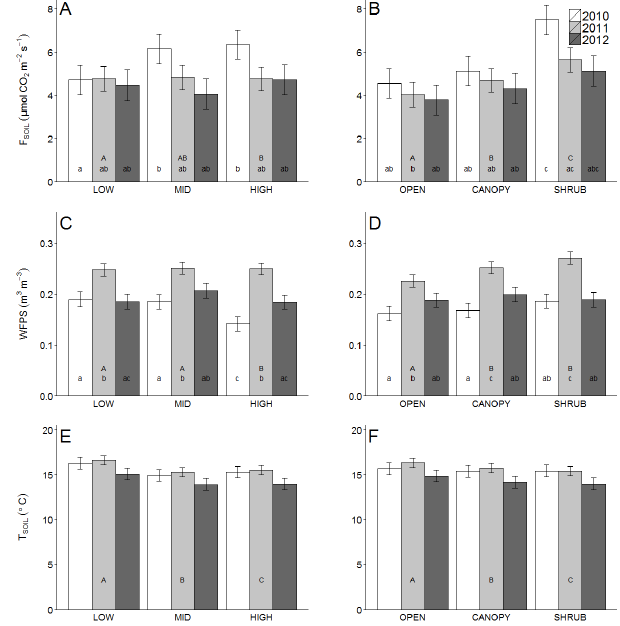
Figure 3. (a, c, e) Least-squares means of soil CO 2 efflux (µmolCO 2 m − 2 s − 1 ) ; WFPS (m 3 m − 3 ) ; and soil temperature at 12cm ( ◦ C) by elevation. (b, d, e) Least-squares means of soil CO 2 efflux (µmol CO 2 m − 2 s − 1 ) ; WFPS (m 3 m − 3 ) ; and soil temperature at 12cm ( ◦ C) by vegetation. Capital letters indicate differences be- tween elevation classes and lower-case letters indicate differences between treatment × year interactions. Bars indicate standard error. Colors indicate sampling